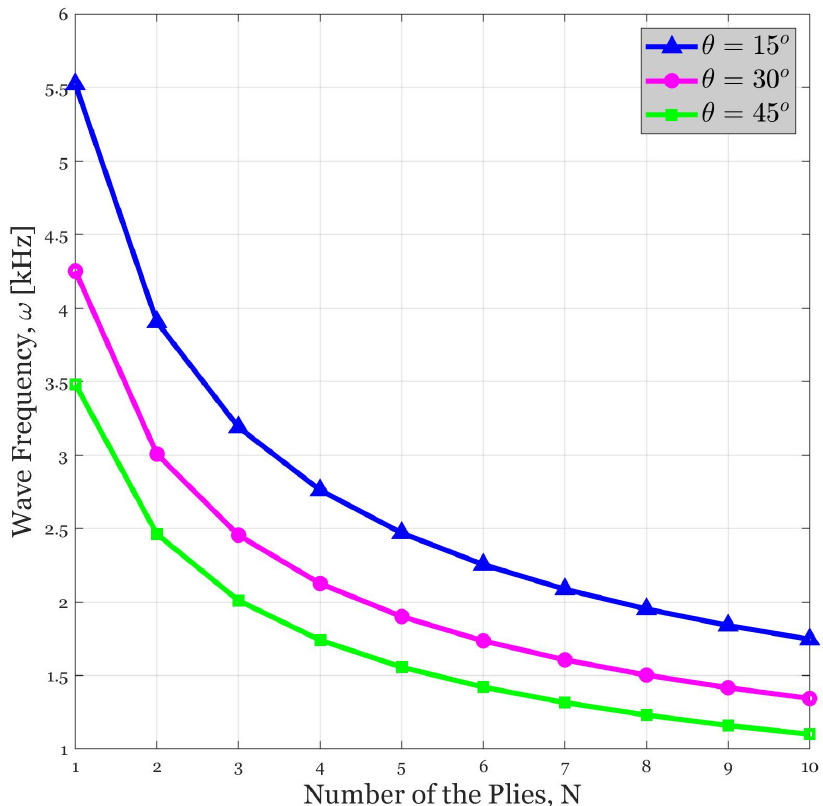
Figure 4. The variation in the wave frequency versus number of the plies for different amounts of the fibers’ orientation angle ( β = 2).